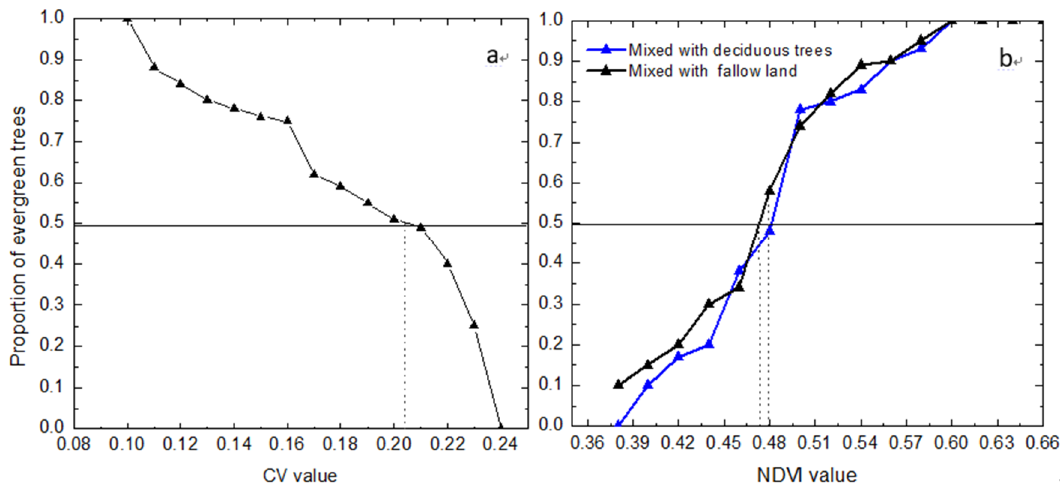
Figure 5. Model threshold analysis results: variation in proportion of evergreen trees with changes in ( a ) the CV in mixed pixels of evergreen trees and deciduous trees, and ( b ) the NDVI in two types of mixed pixels composed of evergreen trees and another vegetation type.